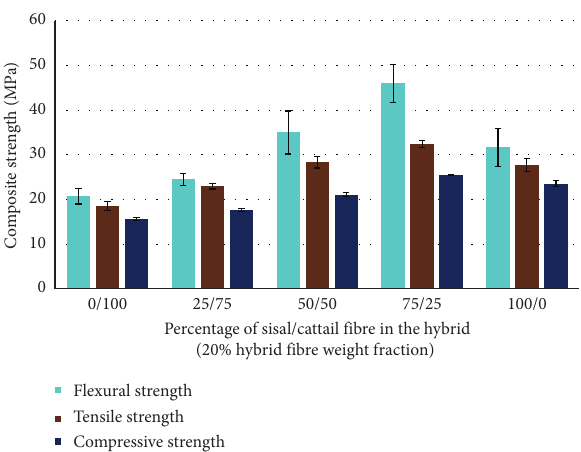
Figure 7: Flexural, tensile, and compressive strengths of hybrid composites at a constant fibre weight fraction of